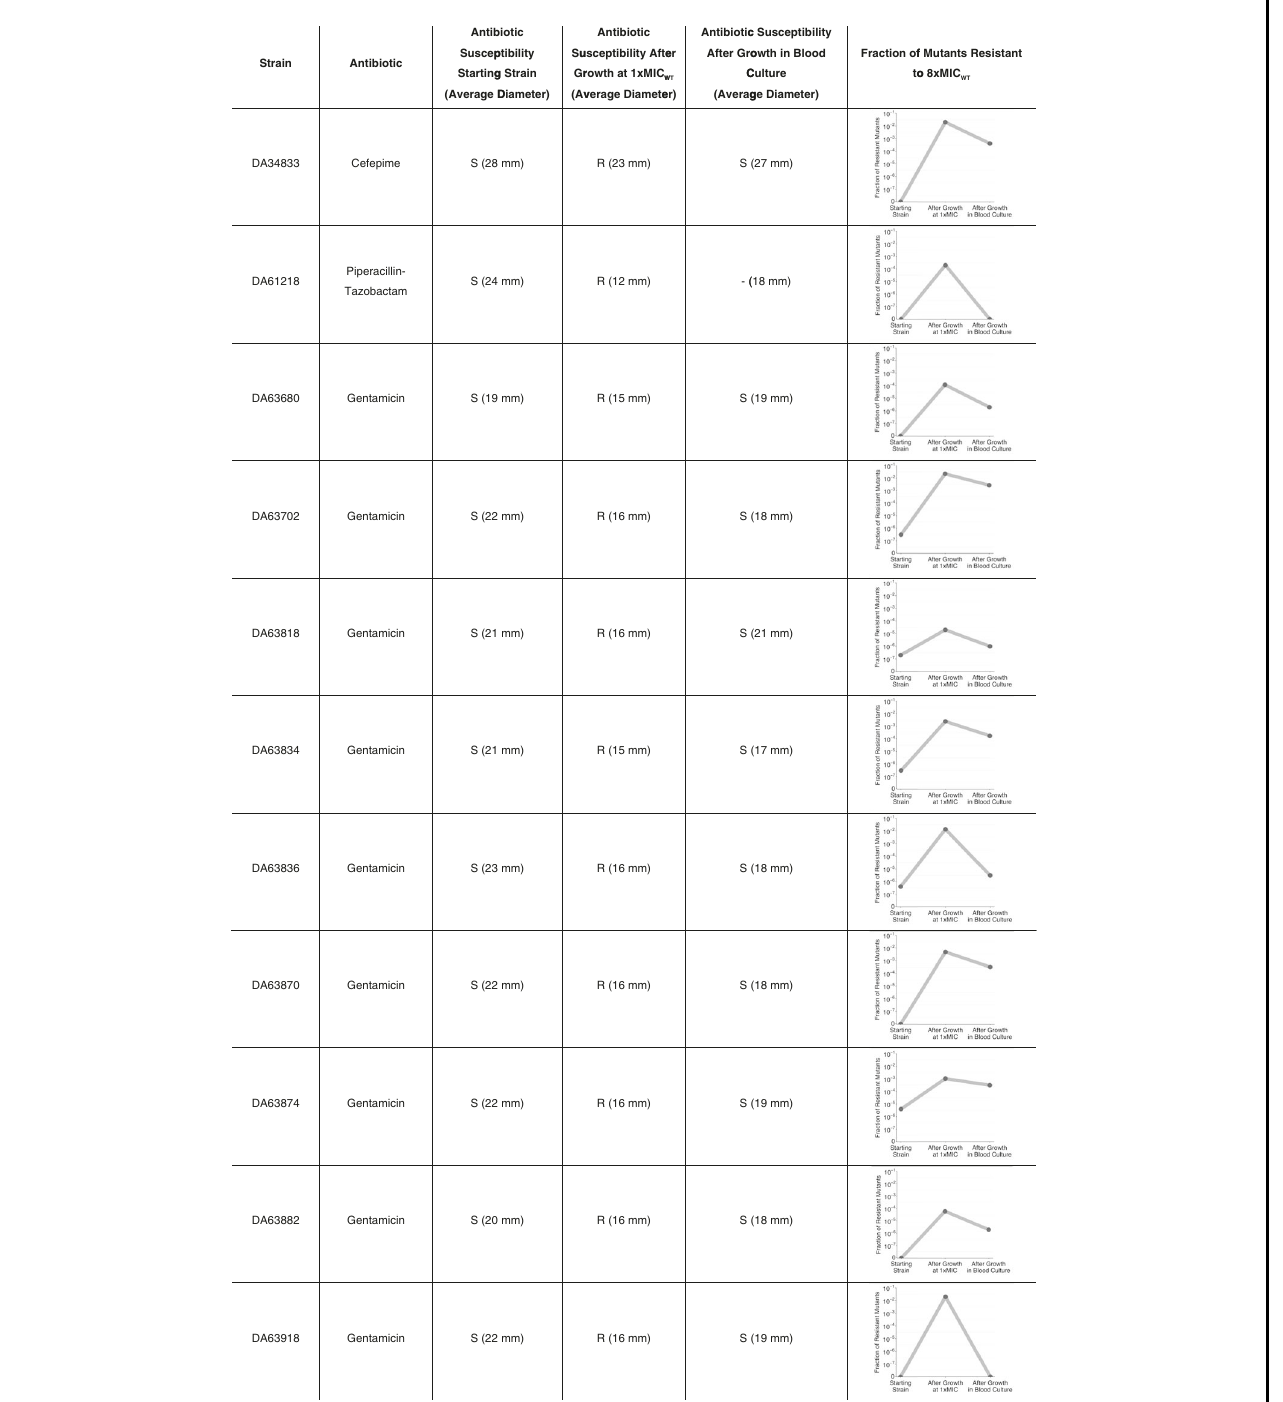
Table 3 Antibiotic susceptibility of heteroresistant isolates before and after growth at 1x the MIC of the parental strain and after growth in blood culture determined by disk diffusion (average diameter) and respective fraction of mutants resistant to 8x the MIC of the parental